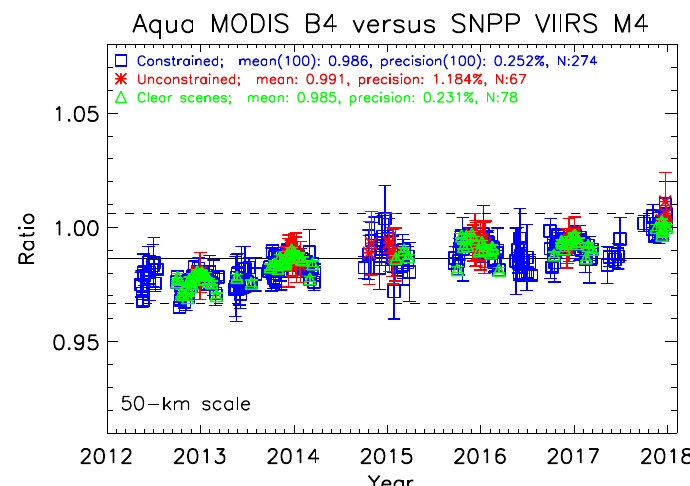
Figure 11. The three time series of Aqua MODIS B4 versus SNPP VIIRS M4 correspond to the constrained analysis using homogeneity and sample size constraint, the unconstrained case and the clear-scene result.